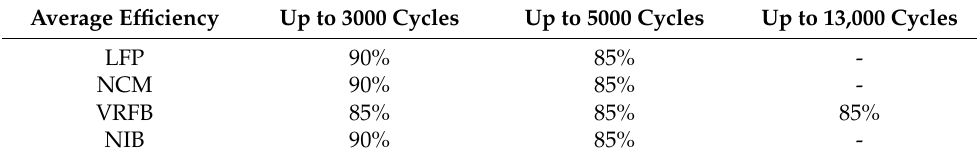
Table 1. Average operating efficiency of the batteries based on the number of life cycles. Average